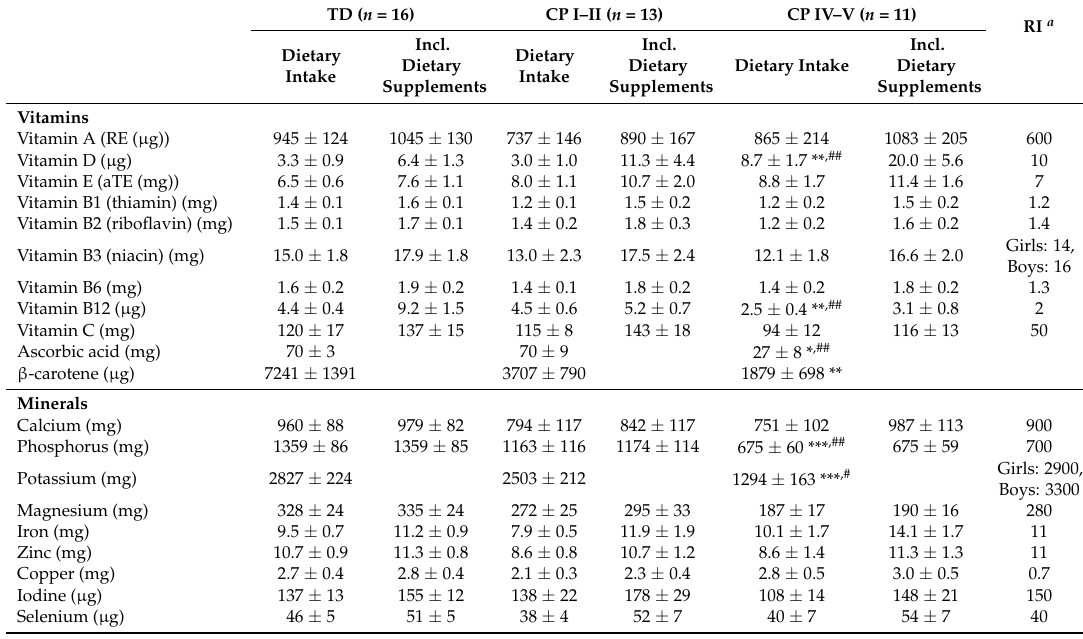
Table 4. Daily intake of